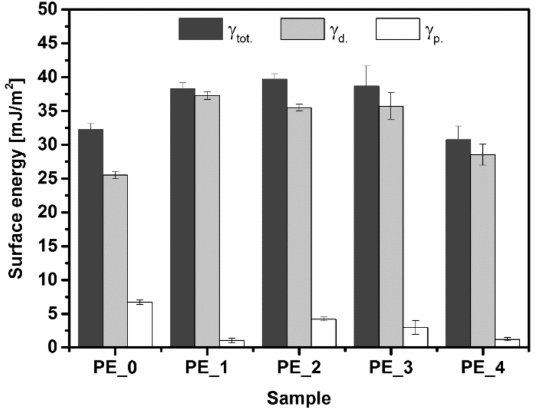
Figure 5. Surface free energy ( γ tot. —total surface energy, γ d. —dispersive surface energy, γ p. —polar surface energy) of unmodified and modified polyethylene, calculated using two different measuring